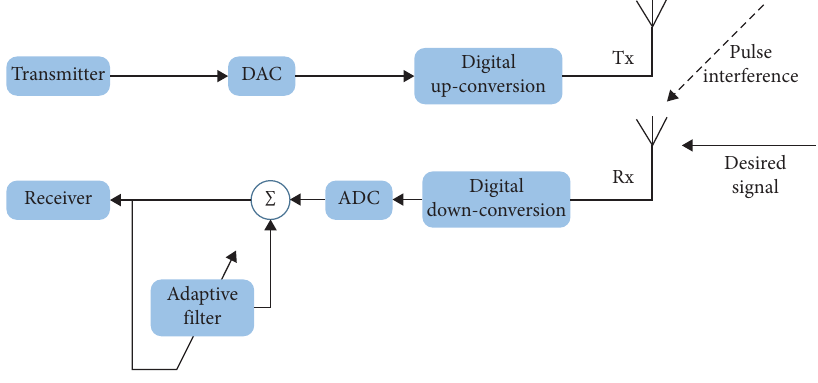
Figure 2: Diagram of pulse interference